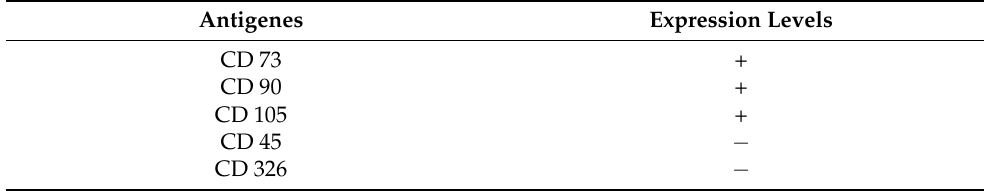
Table 1. Flow cytometry analysis of the hGDFs’ phenotype.